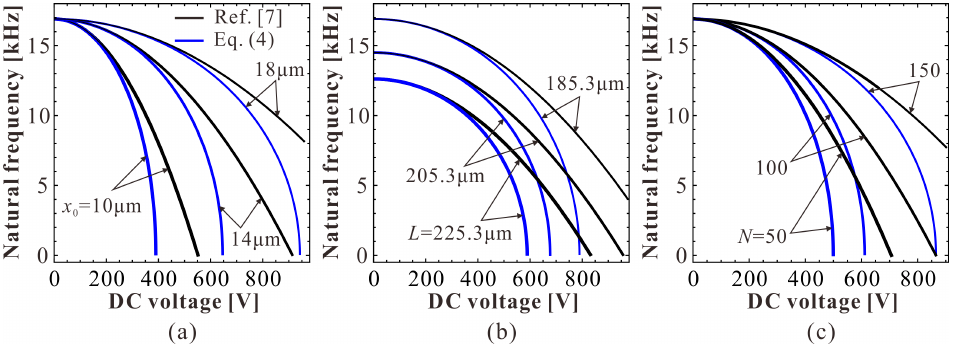
Figure 14. The effects of different physical parameters on the natural frequency of the resonator. ( a ) The effect of initial lateral spacing; ( b ) the effect of beam length; ( c ) the effect of total number of fingers.